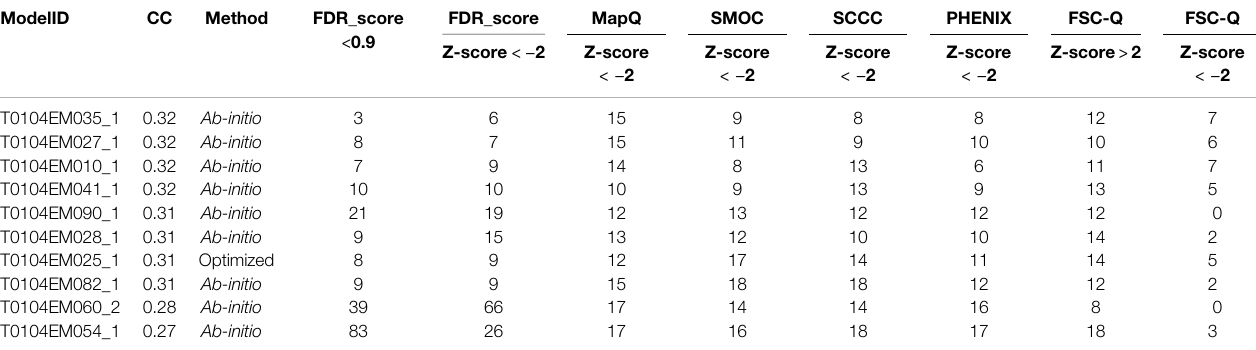
TABLE 1 | Outlier detection by different metrics for ten of the models submitted to the 2019 Model Challenge for the target alcohol dehydrogenase map (EMD-0406). For each model, the table number of residues of chain A associated with Z-scores lower than − 2.0. For the FDR backbone score, the table also shows the number of residues with an FDR backbone score less than